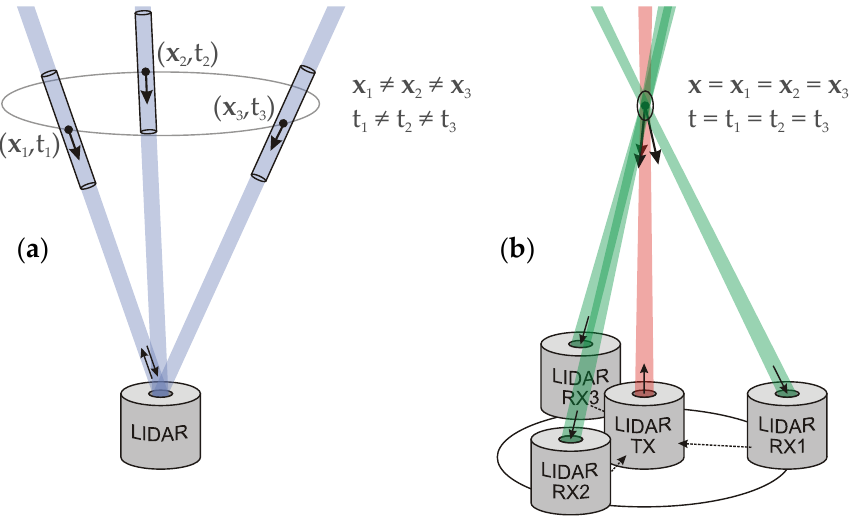
Figure 2. ( a ) A conventional monostatic lidar uses a single combined transmitter and receiver, resulting in a large measurement volume which needs to be multiplexed spatially and temporally by sequentially tilting the beam and sampling the wind speed. ( b ) The PTB bistatic lidar uses three separate receivers ( RX1 , RX2 , RX3 ) around a central transmitter ( TX ), facilitating the simultaneous measurement of the three wind velocity components with high spatial and temporal